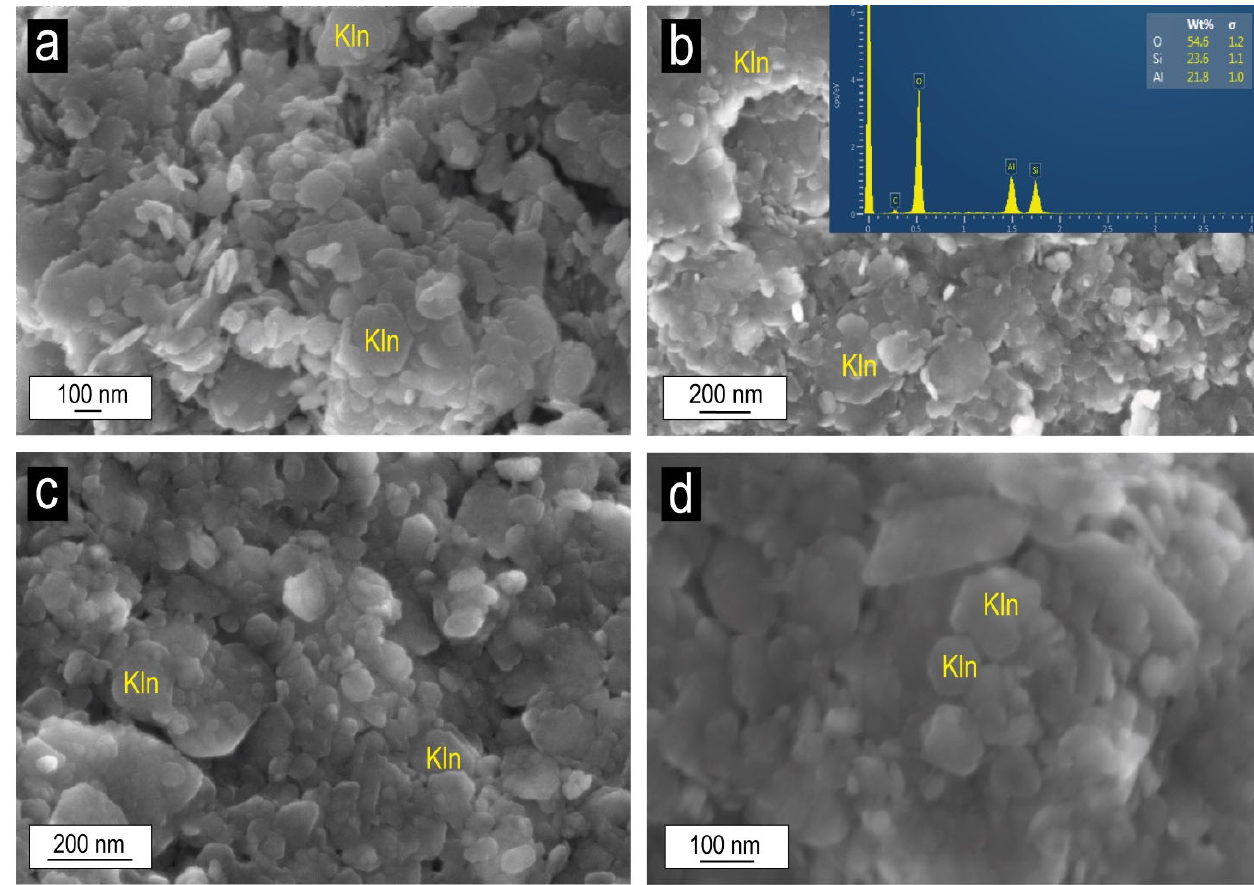
Figure 5. Secondary electron microscopy images of terrestrial ( a , b ) and submerged ( c , d ) samples showing subeuhedral to euhedral kaolinite plates occasionally displaying hexagonal outlines. Kln = kaolinite. Figure 5b includes an EDS pattern of kaolinite from the terrestrial samples.